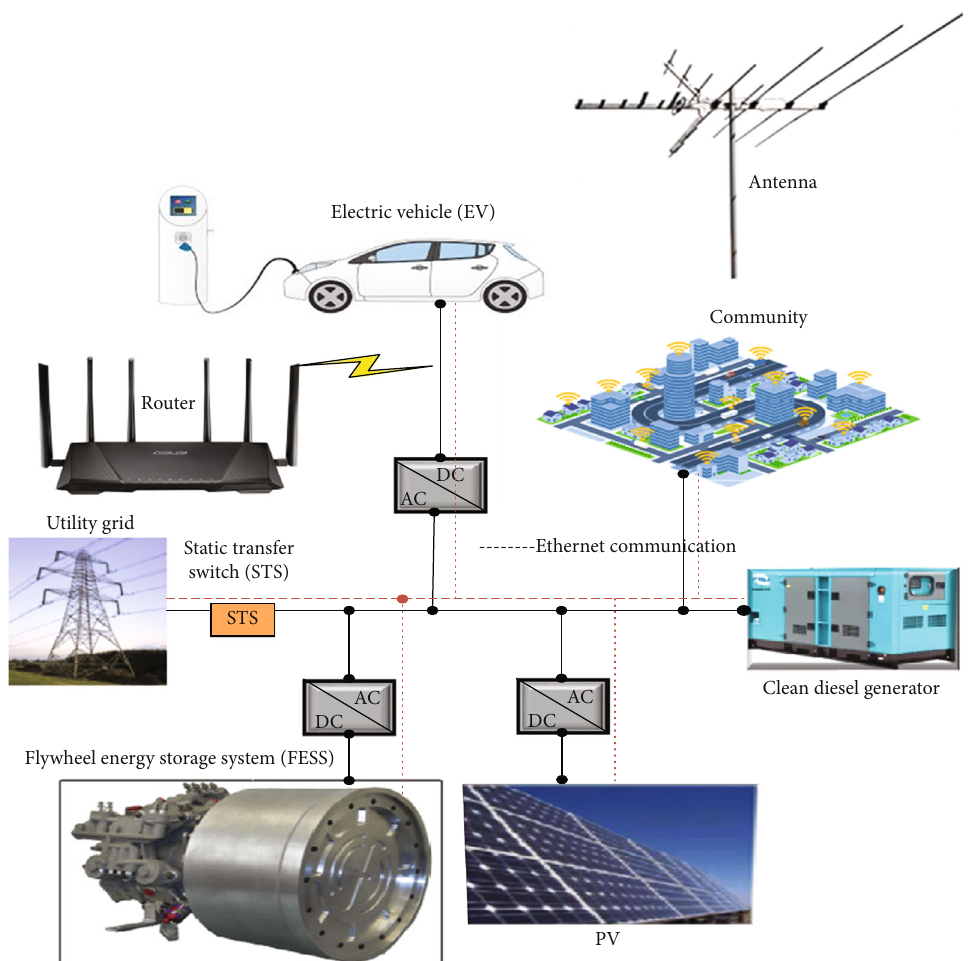
Figure 1: Diagram of microgrid with di ff erent distributed energy resources (DERs). Note: the fi gure is based on the authors ’ understanding and analysis of di ff erent energy technology exploitations and the desire of EV exploitation for Rwandan market; no source or reference is linked to the fi